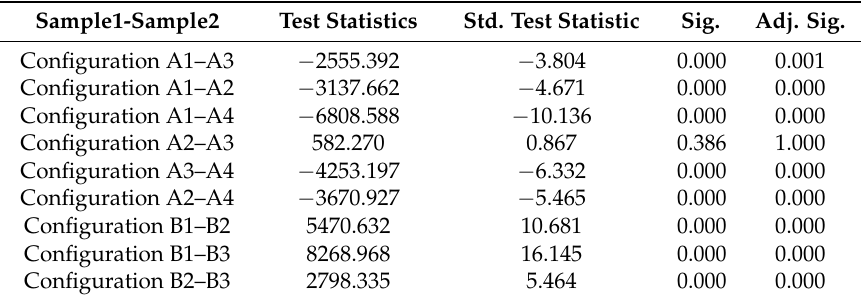
Table 20. Comparisons of two parameters under different configurations.